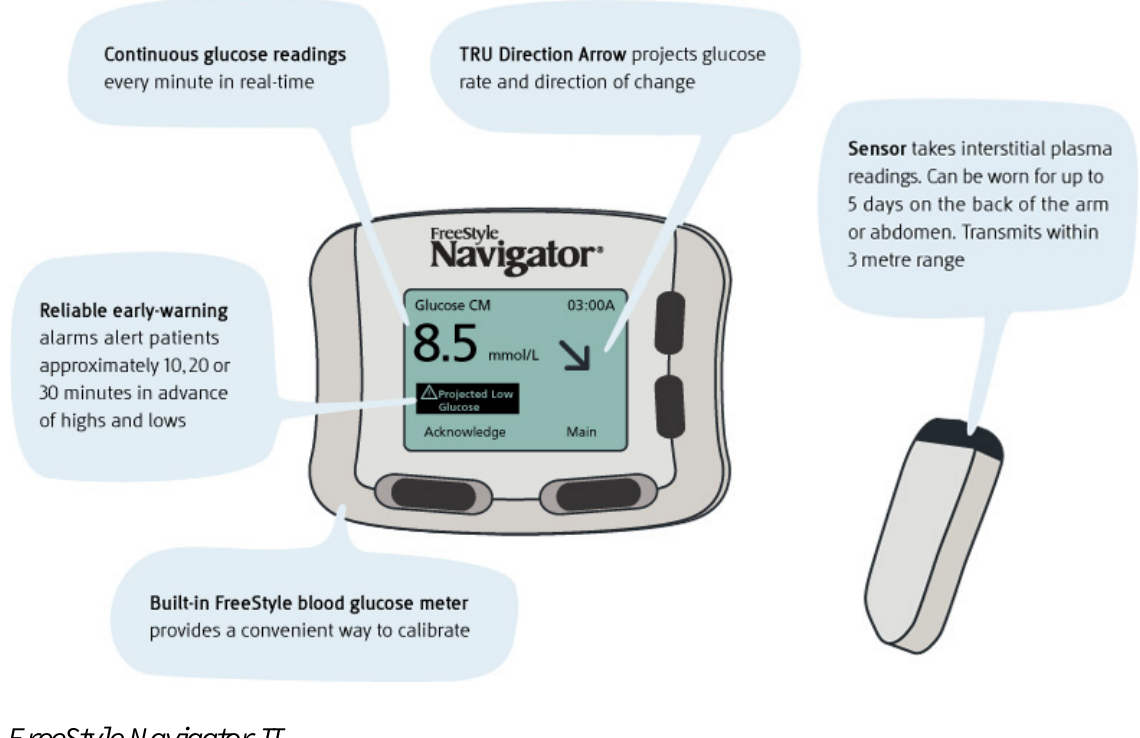
Figure 3. Visual interpretation of the indicators on